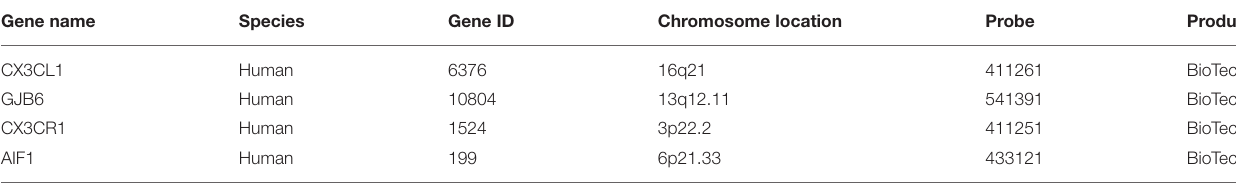
TABLE 2 | Gene Information for RNAscope probe designing or purchase.